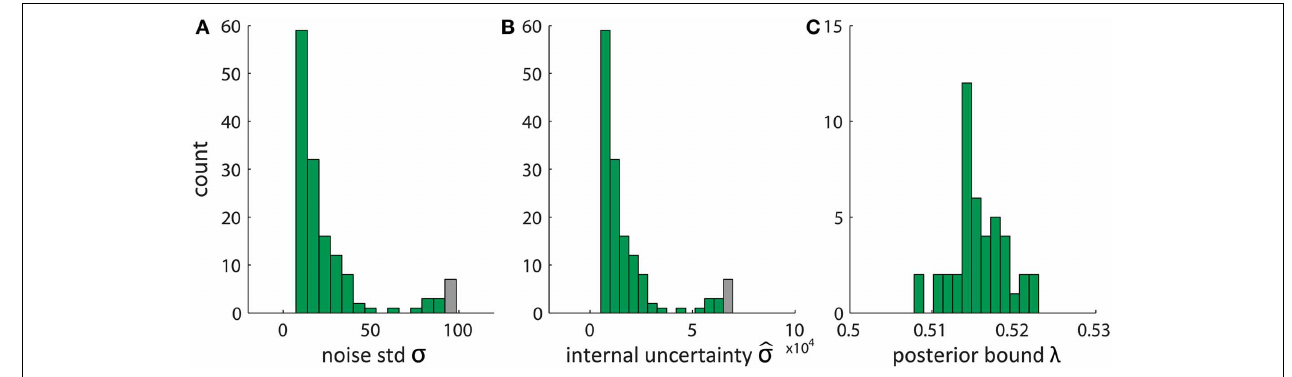
FIGURE 2 | Estimated parameters of Bayesian model derived from pDDM fits by translating the set of pDDM parameters presented in Wagenmakers et al. (2007). (A) Noise standard deviation σ , (B) internal